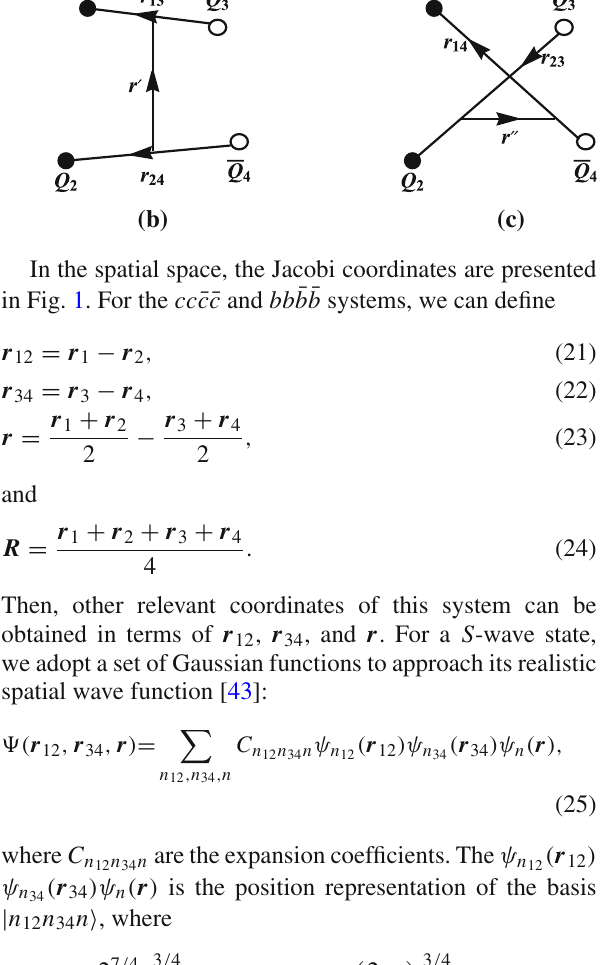
Fig. 1 The Q 1 Q 2 ¯ Q 3 ¯ Q 4 tetraquark state in Jacobi coordinates